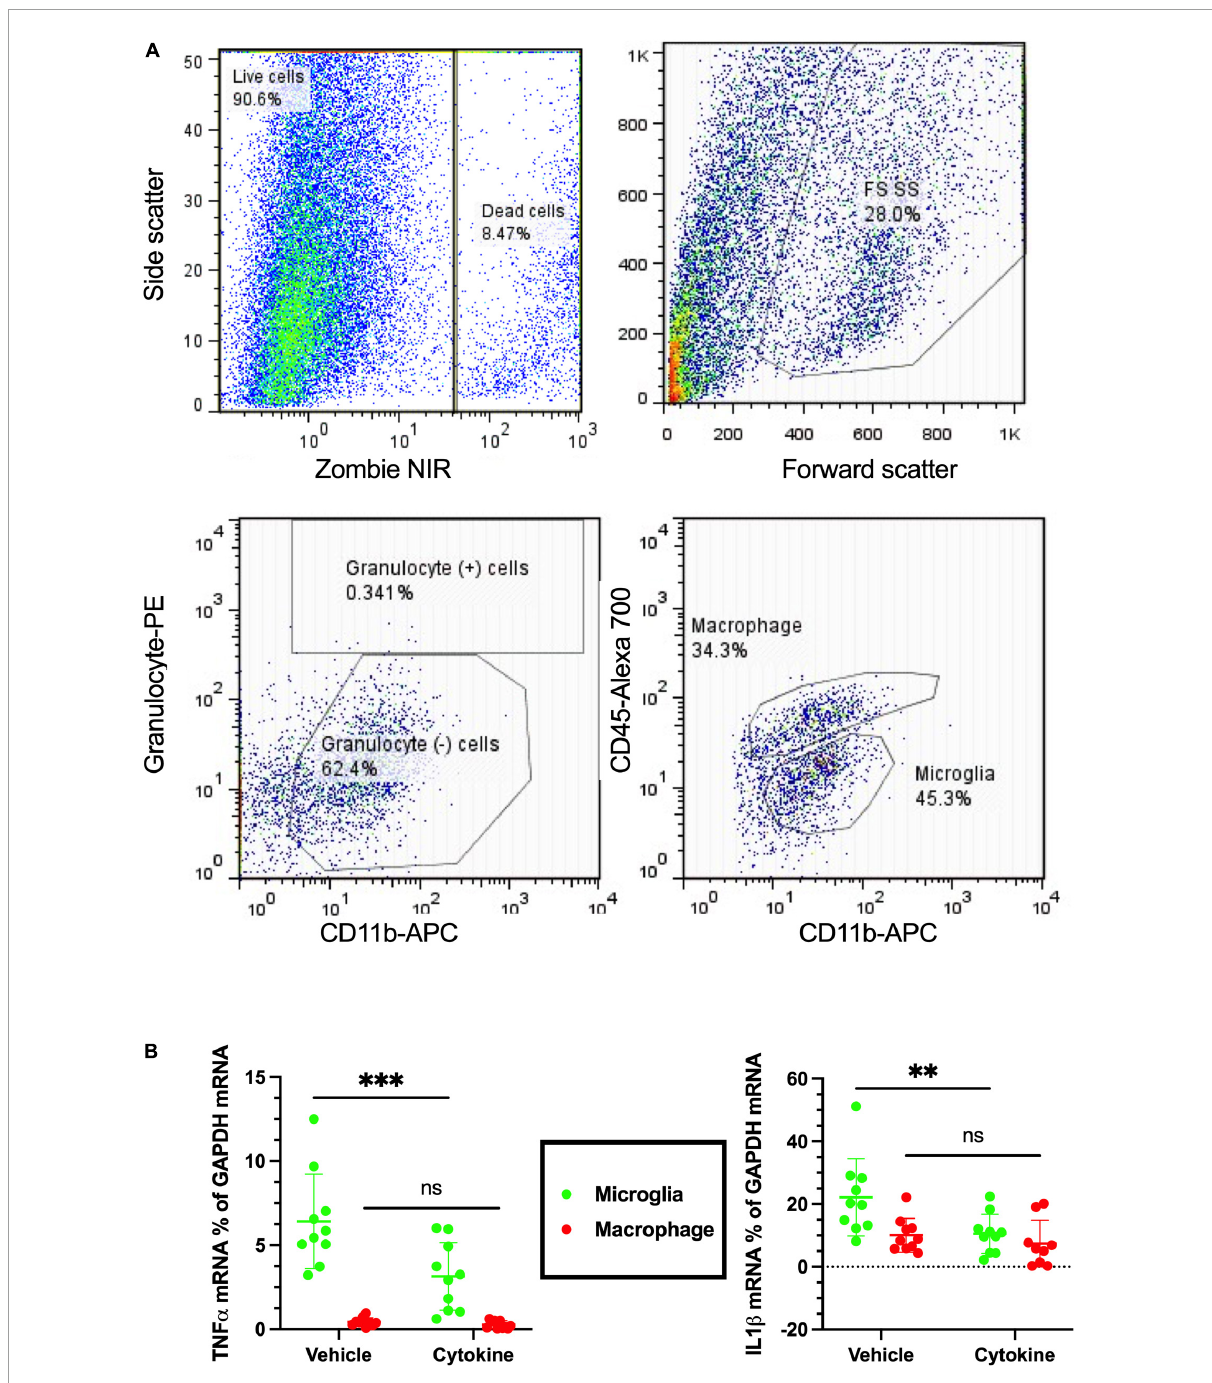
FIGURE4 Cytokines (GM-CSF and IL-3) inhibit microglial release of inflammatory cytokines following ischemic injury at 3 dpr. (A) Flow cytometry gating strategies in which the ischemic hemisphere at 3 dpr is dissociated and gated for granulocyte, macrophage, and microglia sorting. (B) Expression of mRNA by microglia isolated from the ischemic hemisphere by flow cytometry is analyzed by qPCR ( n = 10). Cytokine treatment significantly inhibits microglial release of TNF- α , and IL-1 β , but does not show any changes in macrophages. Data are shown as means ± SD and were statistically analyzed with Student’s t- test. ∗∗ P < 0.01, ∗∗∗ P < 0.001 vs. vehicle. GM-CSF, granulocyte macrophage colony-stimulating factor; IL, interleukin; dpr, days post-reperfusion; TNF, tumor necrosis factor; SD, standard